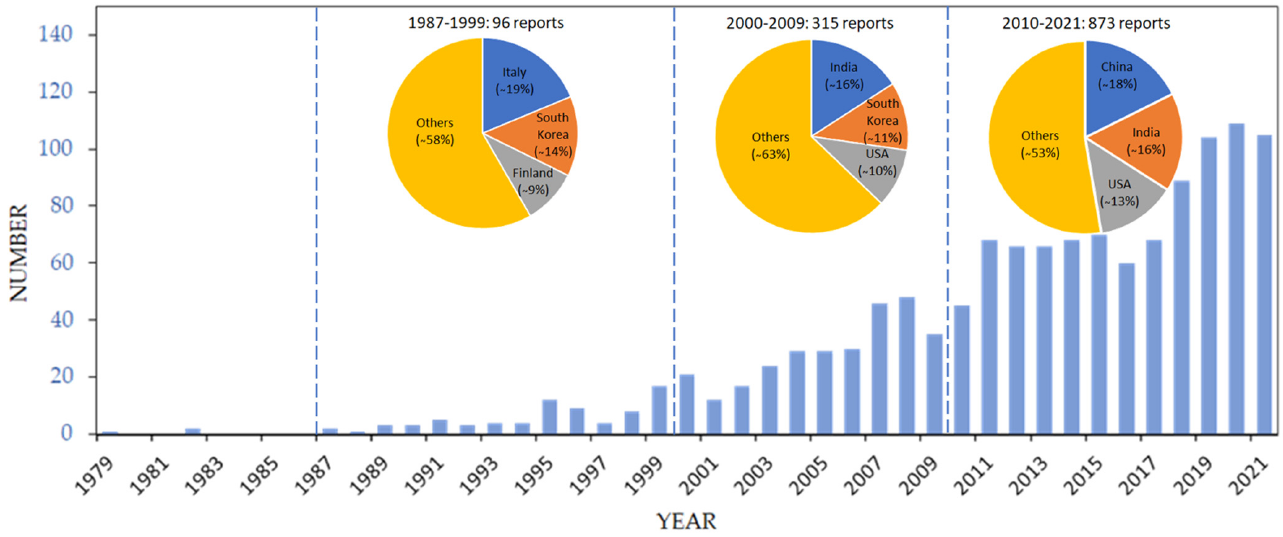
Figure 1. The number of documents published in the printed gas sensor field in 1979–2021 from sources indexed by Scopus (search on 12/04/2022) under the key words of “gas sensor” and “print- ing”. Insets: the top three countries in the field at approximately decade time periods and their relative portion of